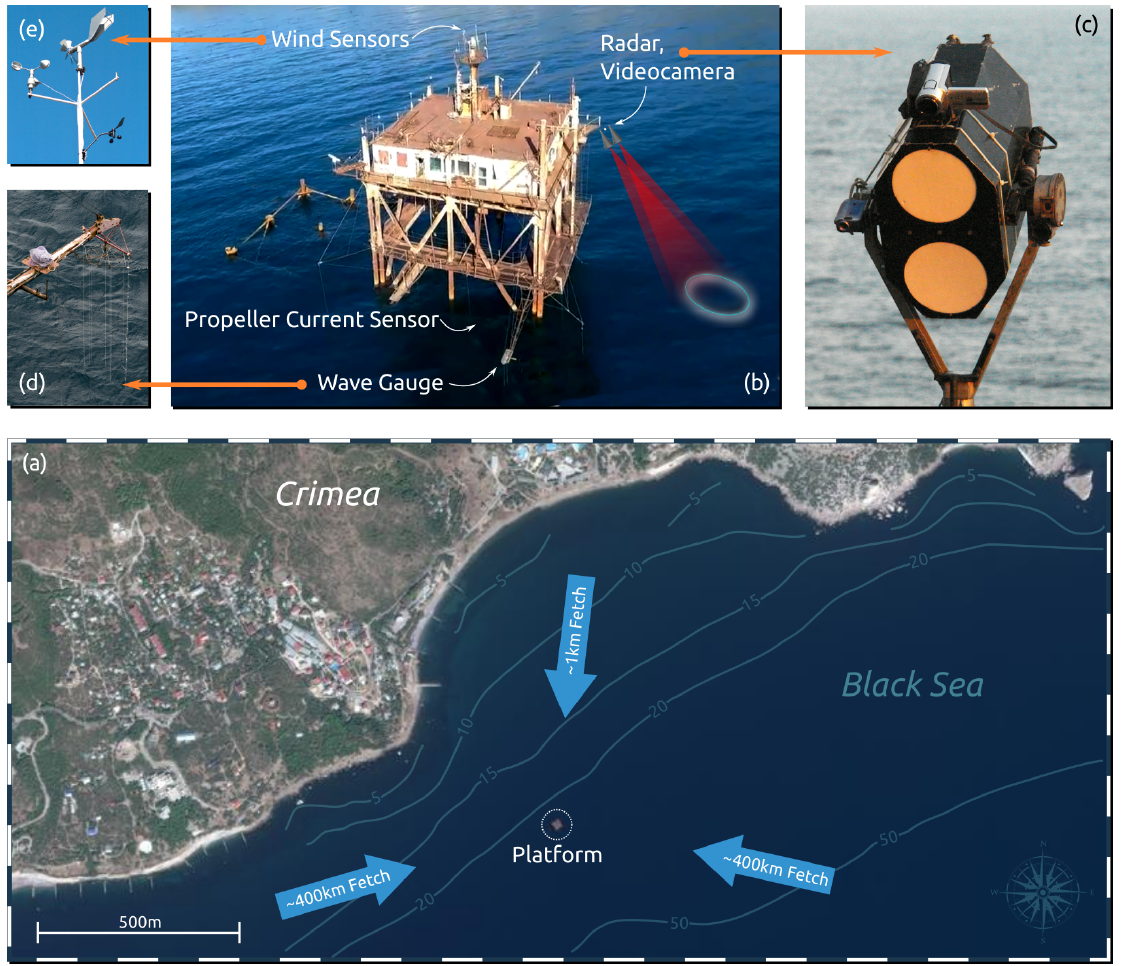
Figure 1. ( a , b ) Black sea research platform with installed ( c ) Ka-band radar, ( d ) wire wave gauge, and ( e ) meteorological